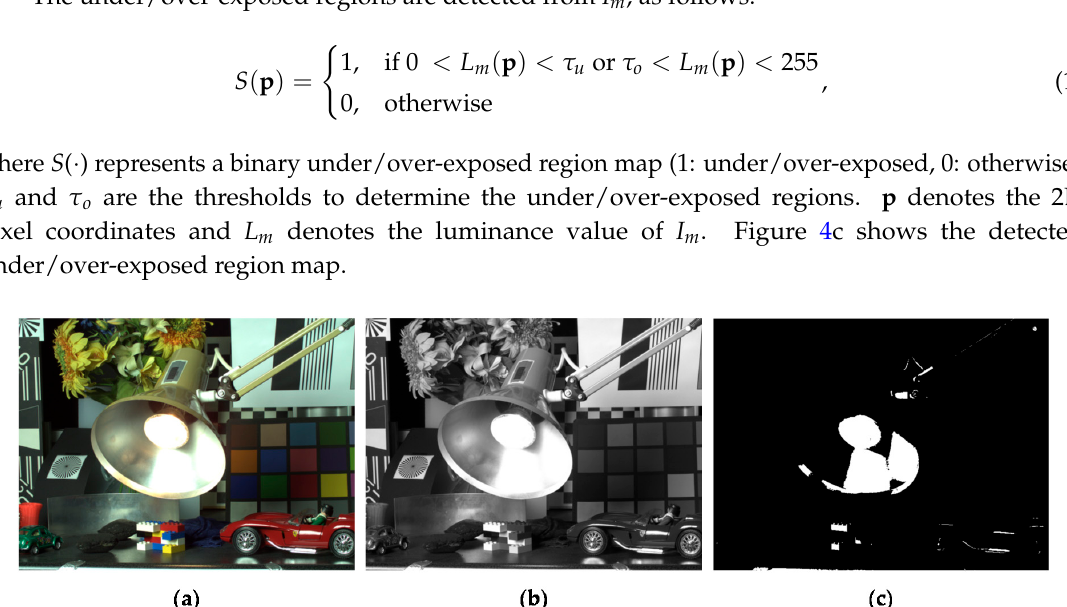
Figure 5. An example of the segmentation process: ( a ) input image; ( b ) resultant image of the super- pixel lattices [20]; and ( c ) resultant image of the graph-based region merging [21].